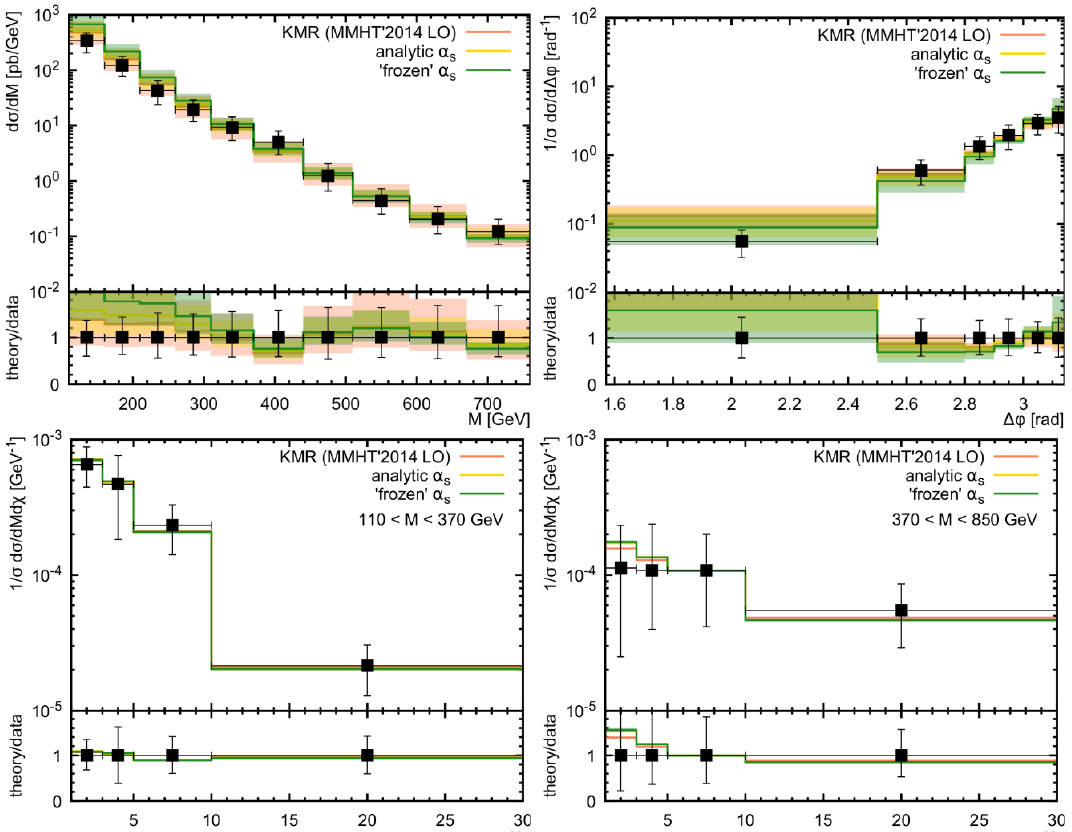
Figure 5 . The dijet invariant mass M , azimuthal angle di(cid:11)erence (cid:1) (cid:30) and (cid:31) distributions of b (cid:22) b -dijet p production at s = 7 TeV. The kinematical cuts are described in the text. The experimental data are from ATLAS